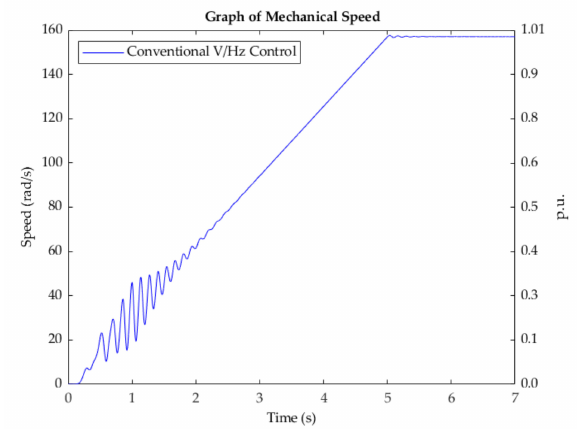
Figure 4. Mechanical speed, conventional V/Hz control, (0–50 Hz).